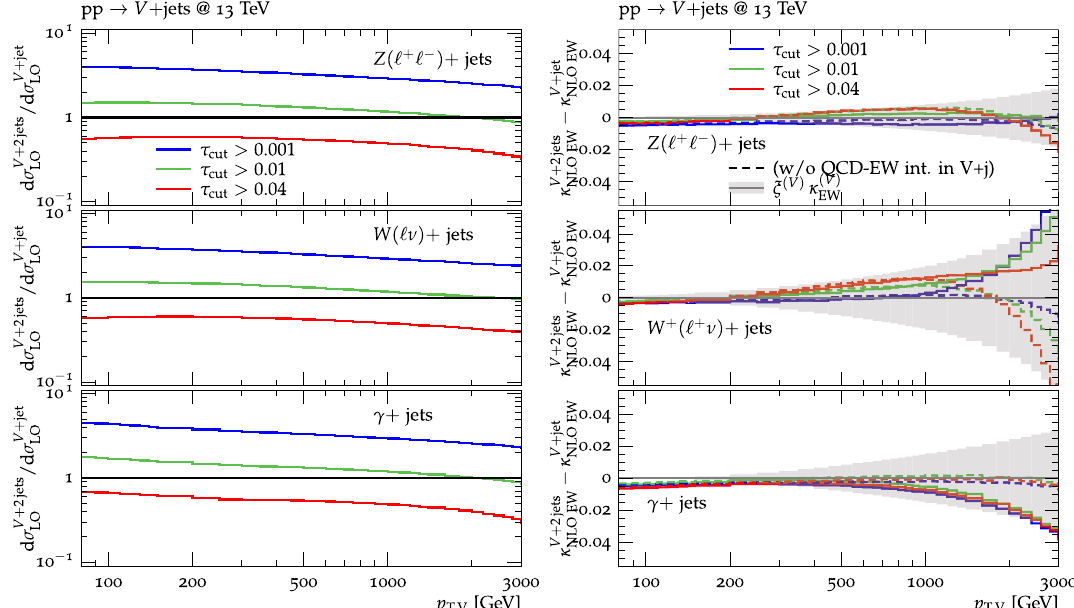
Fig. 15 The left plot shows ratios of the different V + 2jets over V + 1jet predictions at LO for three values of the jettiness resolution parameter τ cut . The right plot shows the estimator of non-factorizing mixed EW–QCD effects (72), i.e. the difference between the EW K - factors for one- and two-jet processes. Results with full EW corrections